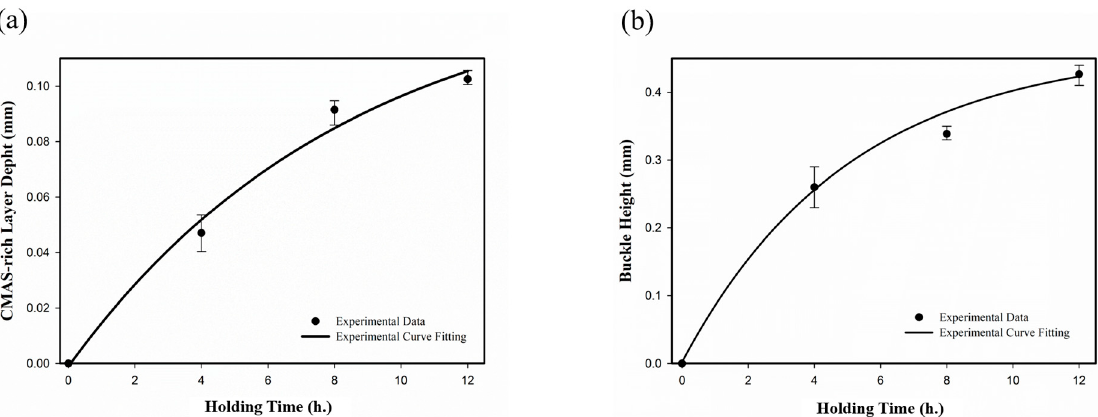
Figure 3. Experimental data with different holding times (4, 8, and 12 h): ( a ) depth of the CMAS-rich layer; ( b ) buckle height of YSZ induced via CMAS infiltration.